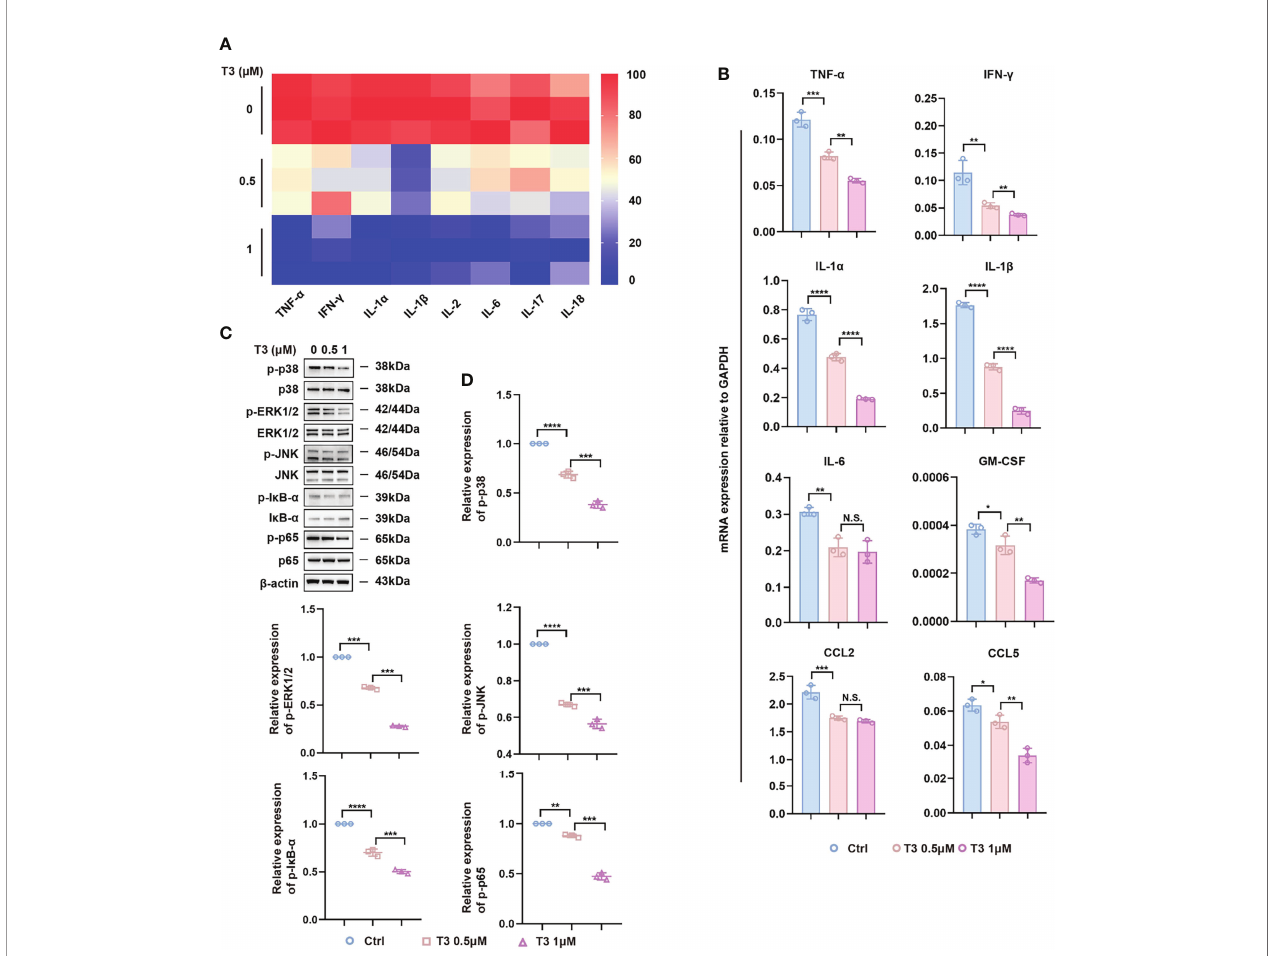
FIGURE 6 | Anti-in fl ammatory effect of T3 in NR8383 cells in vitro. (A) TNF- a , IFN- g , IL-1 a , IL-1 b , IL-2, IL-6, IL-17, and IL-18 protein levels were determined in the cell supernatants by Bio-Plex. (B) RT-PCR analysis of TNF- a , IFN- g , IL-1 a , IL-1 b , IL-6, GM-CSF, CCL2, and CCL5 mRNA in NR8383 cells treated with 500 nM or 1 μM T3. (C) Western blotting assay of MAPK and NF- k B signaling pathways in NR8383 cells treated with 500 nM or 1 μM T3. (D) Densitometry of p-p38, p-ERK1/2, p-JNK, p-I ĸ B- ɑ , and p-p65 was performed followed by normalization. Mean ± SD values were obtained from at least three independent experiments performed in triplicate. Differences were analyzed using one-way ANOVA (*p < 0.05, **p < 0.01, ***p < 0.001, and ****p < 0.0001; N.S., not signi fi